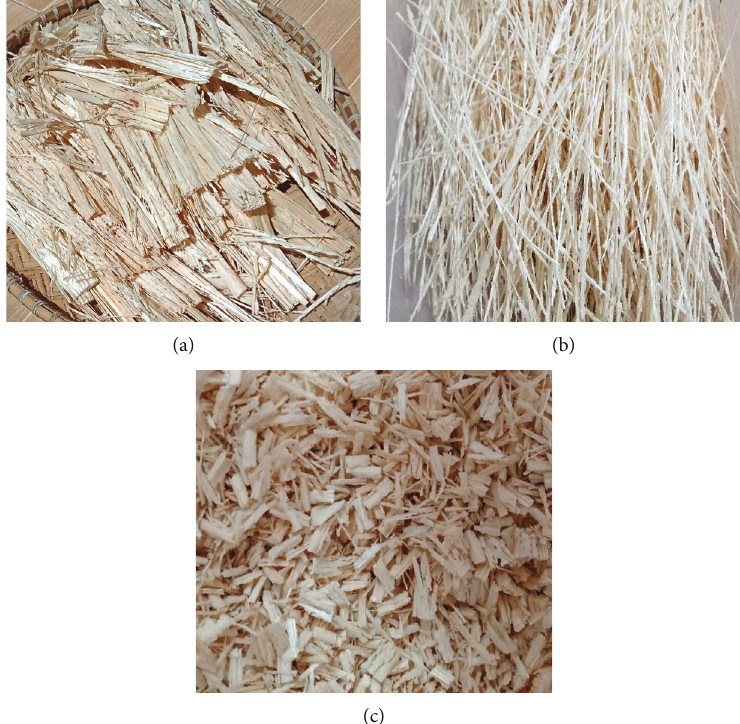
Figure 1: (a) Bagasse, (b) depithed bagasse, and (c) bagasse after cutting into small pieces.